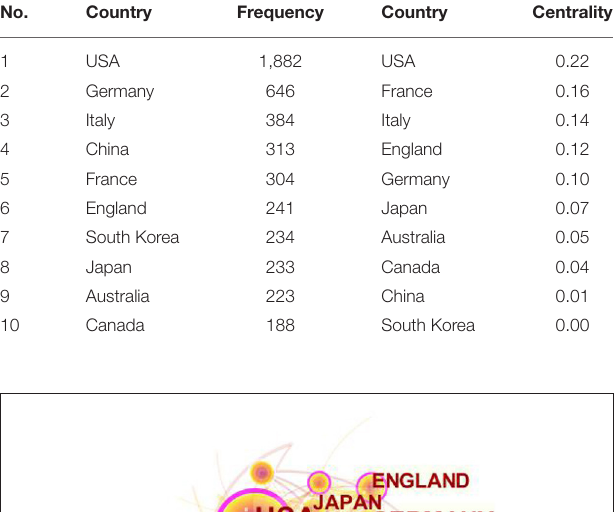
FIGURE 4 | Institution visualization